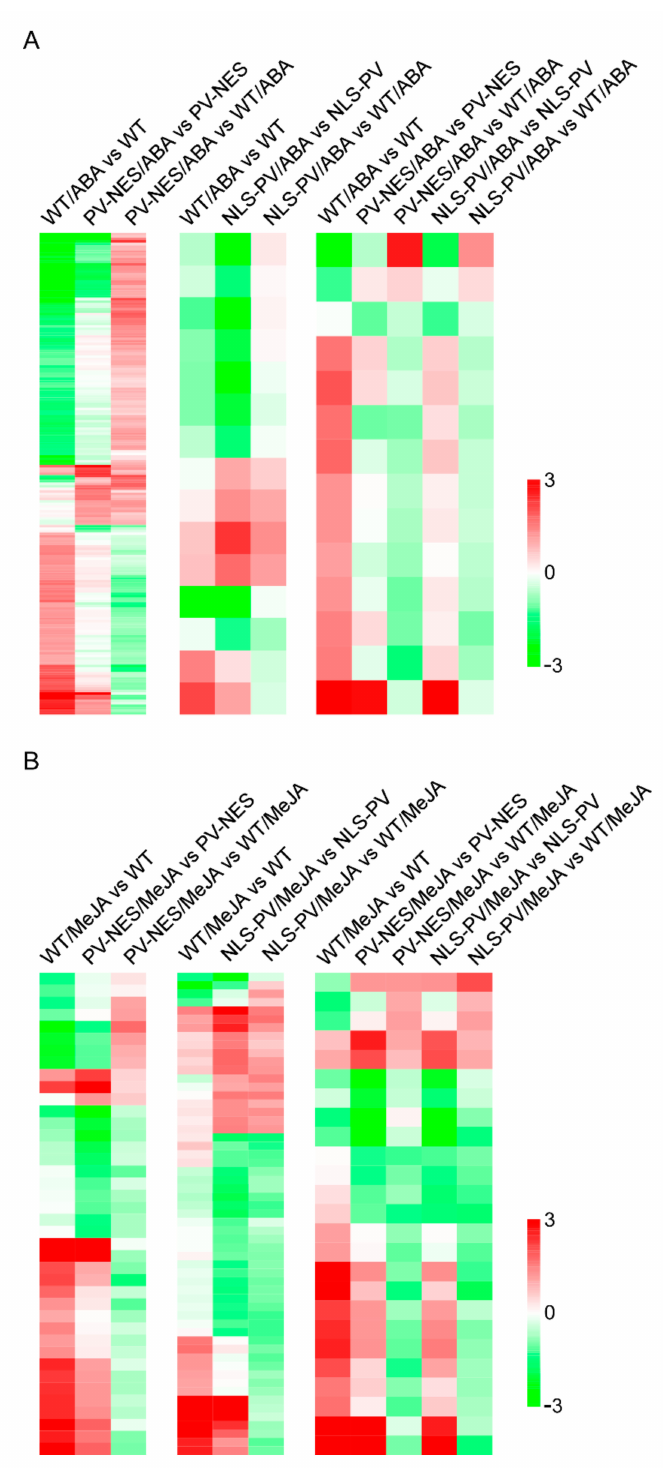
Figure 2. [Ca 2+ ] cyt - and [Ca 2+ ] nuc -regulated phytohormone-responsive genes. Significantly differen- tially expressed gene clusters in WT, PV-NES, and PV-NLS transgenic lines in response to ABA ( A ) and MeJA ( B ) treatment. The left column indicates [Ca 2+ ] cyt -regulated ABA- or MeJA-responsive genes. The middle column indicates [Ca 2+ ] nuc -regulated ABA- or MeJA-responsive genes. The right column indicates [Ca 2+ ] cyt - and [Ca 2+ ] nuc -regulated ABA- or MeJA-responsive genes. Microarray comparison results represented by each column are indicated at the top of the figure. Each row represents one gene; colours represent changes in gene expression levels as indicated. Quantitative data for each gene are shown in Tables S2 and